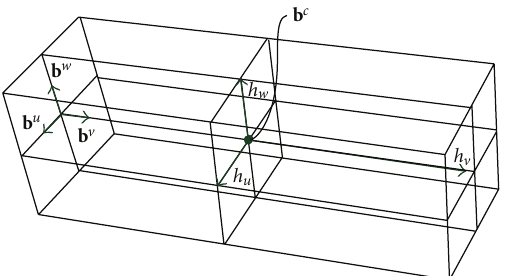
Figure 5: Oriented 3D bounding box: b c is the centre point, together with normalized and positive-oriented side vectors b u , b v , and b w . The vectors h u , h v , and h w are the distances from the centre of the box to the centre of its faces.